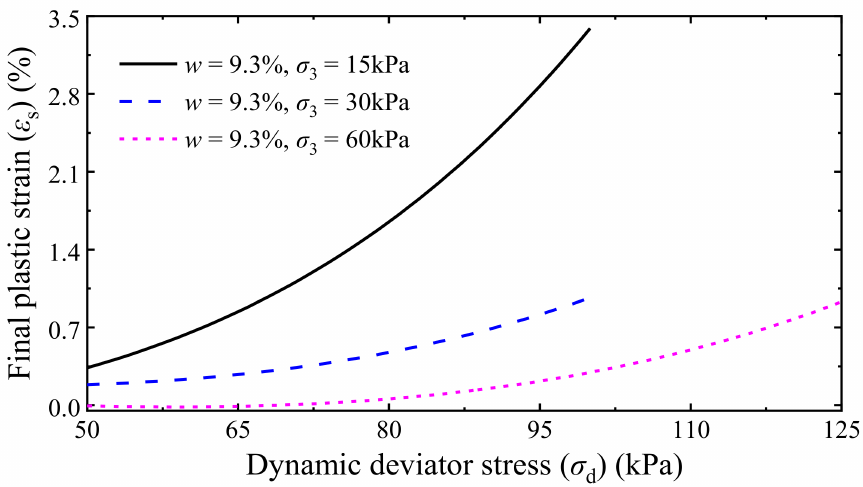
Figure 14. ε s – σ d relationship of saturation